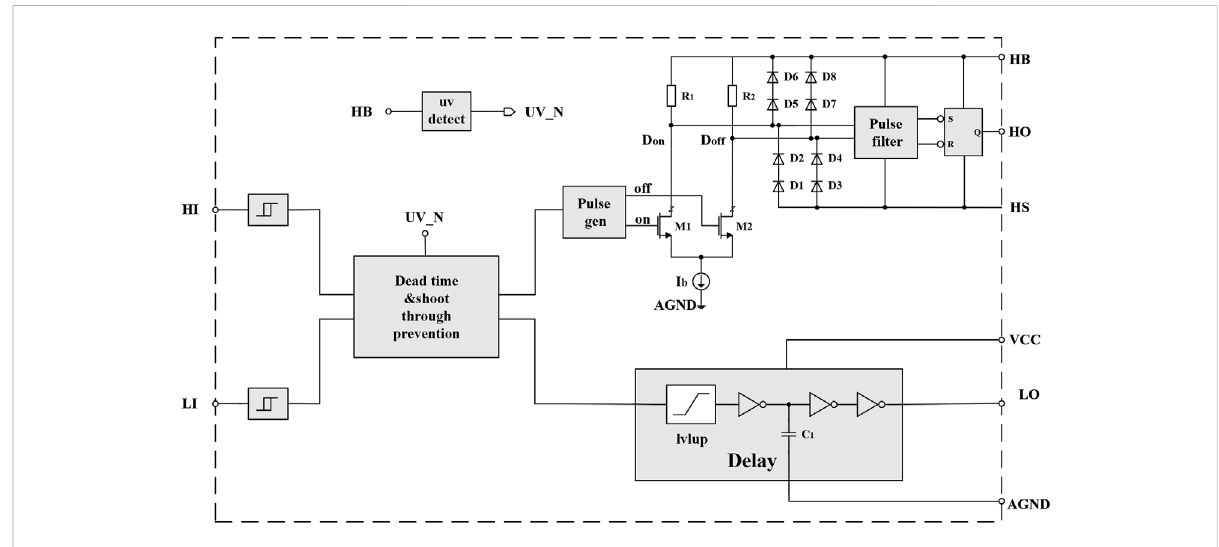
FIGURE 4 Circuit realization of the predriver